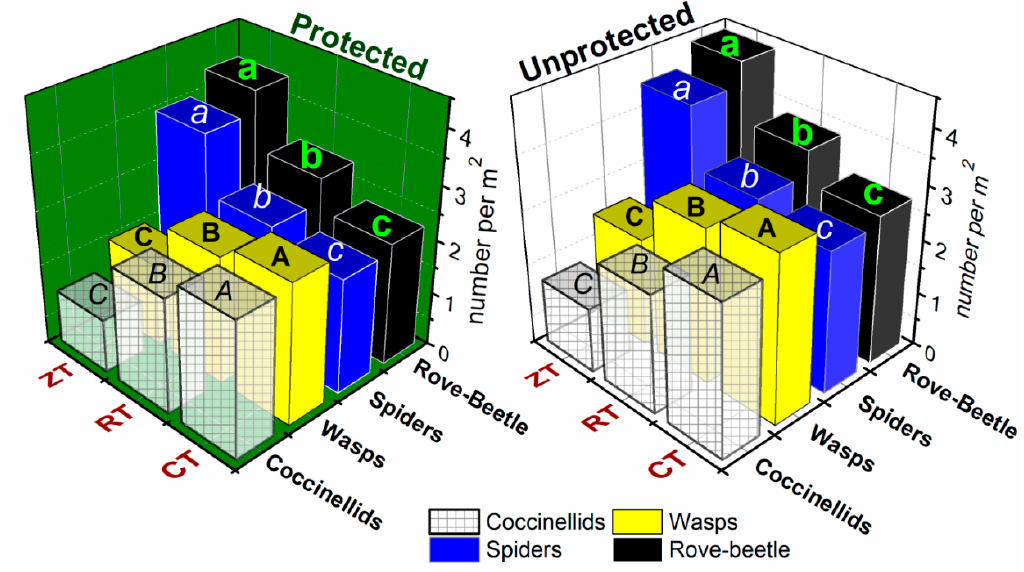
Figure 7. Populations of major natural enemies (number per m 2 ) in wheat grown under 3 tillage practices during 2016–2017 and 2017–2018 (pooled). For each predator type, bars with the same letters are not significantly different at p < 0.05. Error bars denote ± 1 SE.